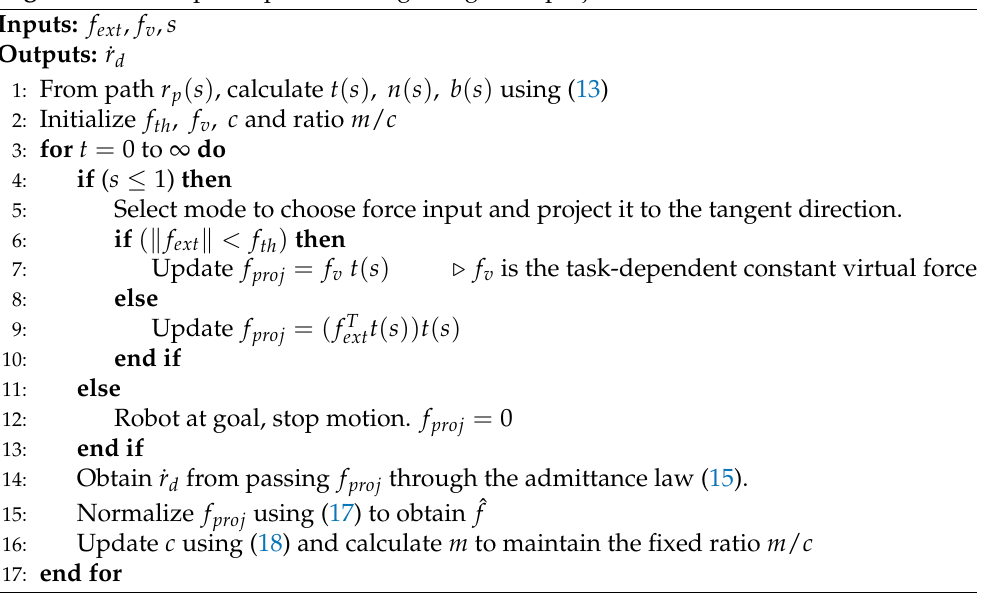
Algorithm 1 Compliant path tracking using force projection